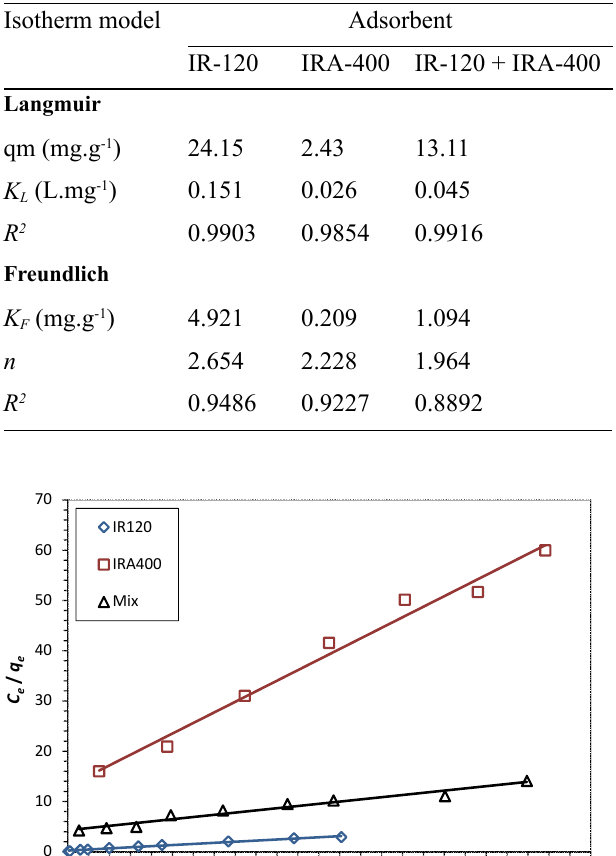
Table 7. Langmuir and Freundlich constants for the adsorption of Th(IV) onto ion exchange resins.